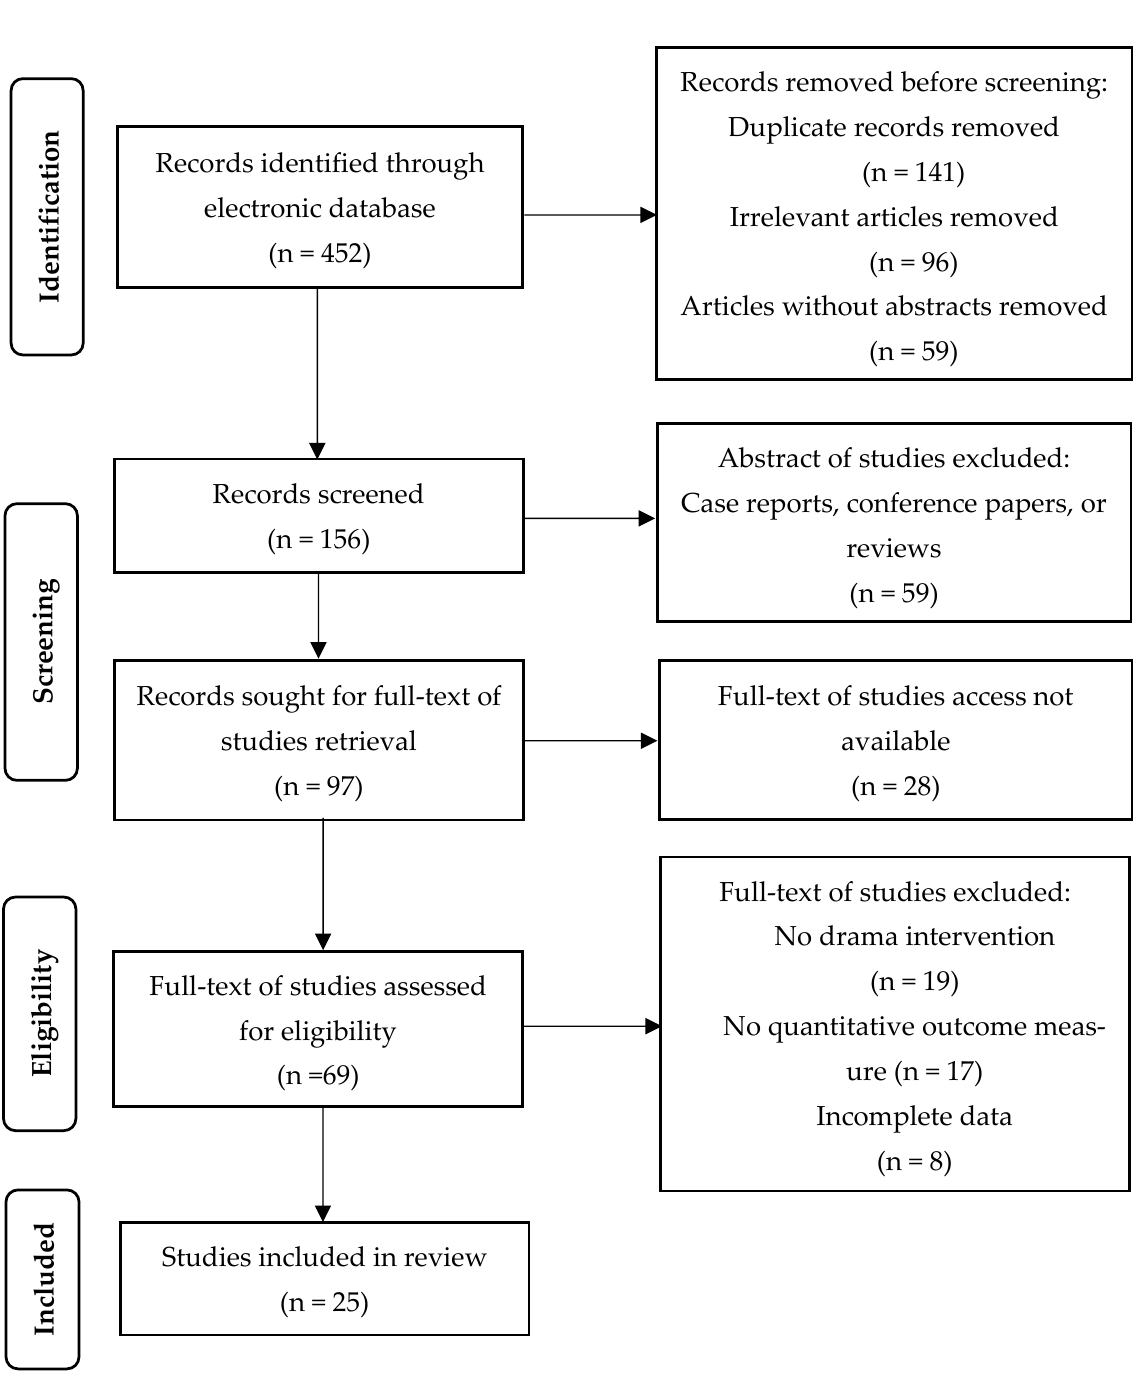
Figure 1. Flow diagram of literature selection. 203